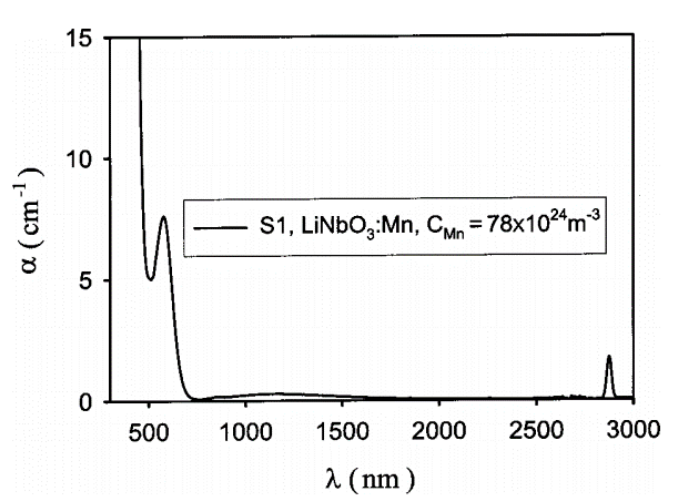
Figure 17. Absorption coefficient of LiNbO 3 doped with manganese